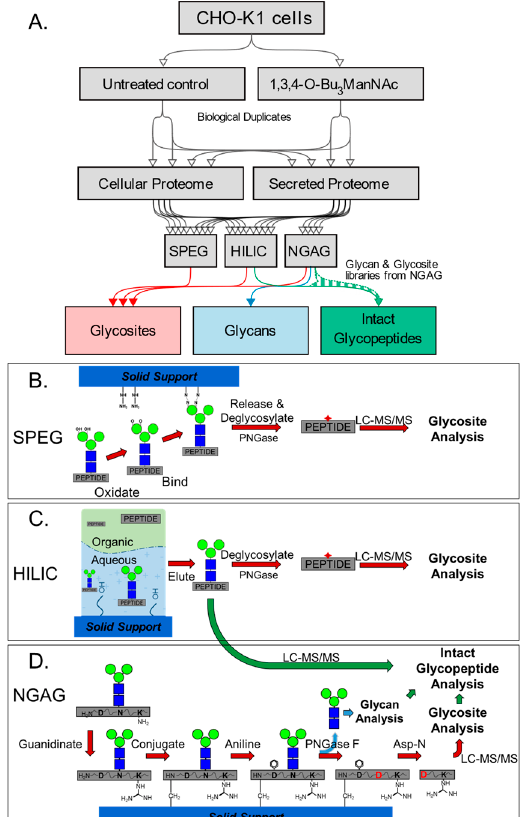
Figure 1. Experimental workflow and schematic of each glycoproteome enrichment method. ( A ) Duplicate samples of Chinese hamster ovary (CHO-KI) cells expressing recombinant human erythropoietin were untreated control or treated with 1,3,4- O- Bu 3 ManNAc. Proteins were harvested